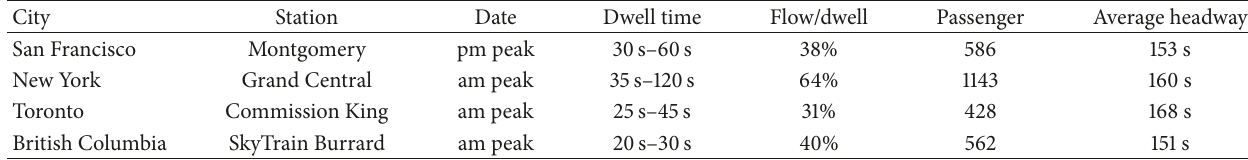
Table 9: The distribution of the worldwide subway dwell